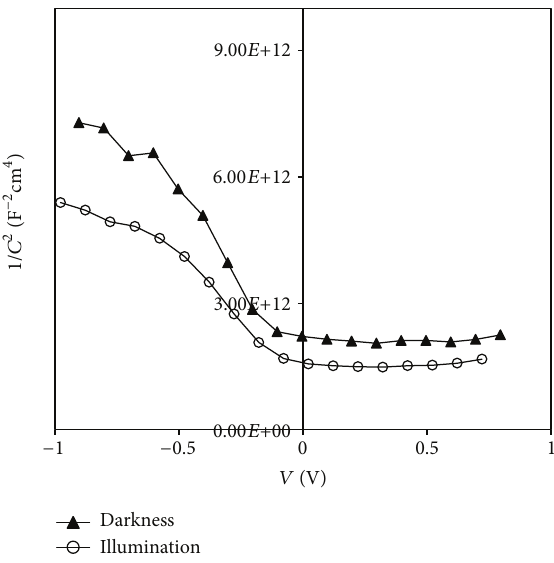
Figure 4: 𝐶 - 𝑉 curves of ITO/EB-MWCNT/ZnO-riboflavin/ITO structure under darkness and